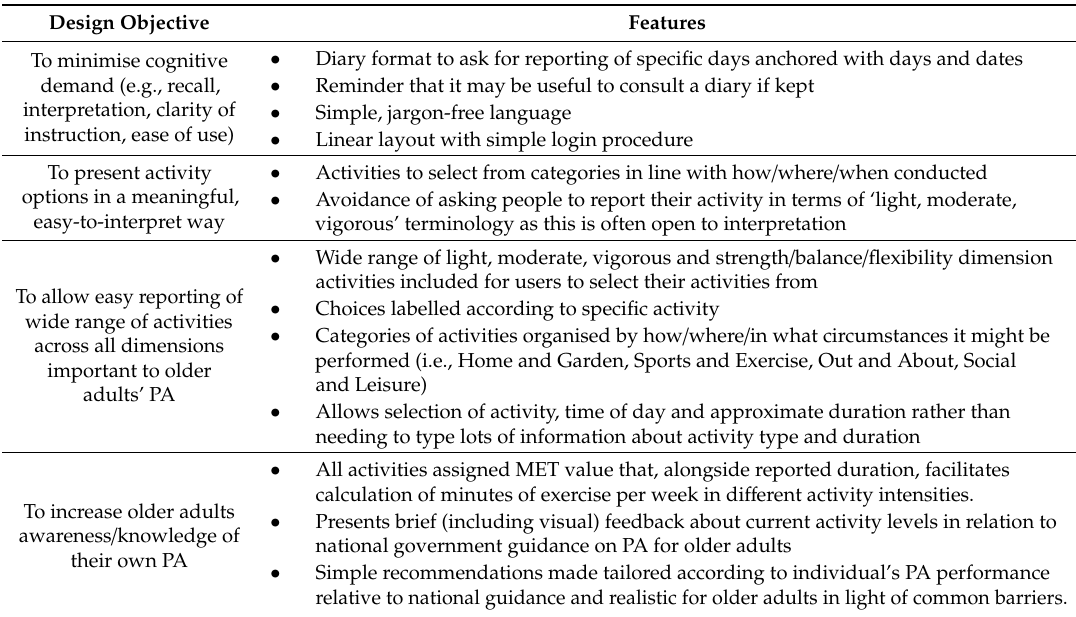
Table 3. Guiding Principles for the development of the DAPPA